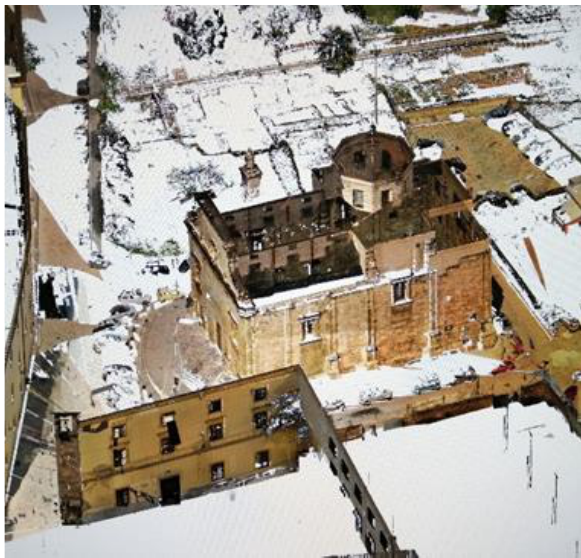
Figure 4. TLS reconstruction of the church and